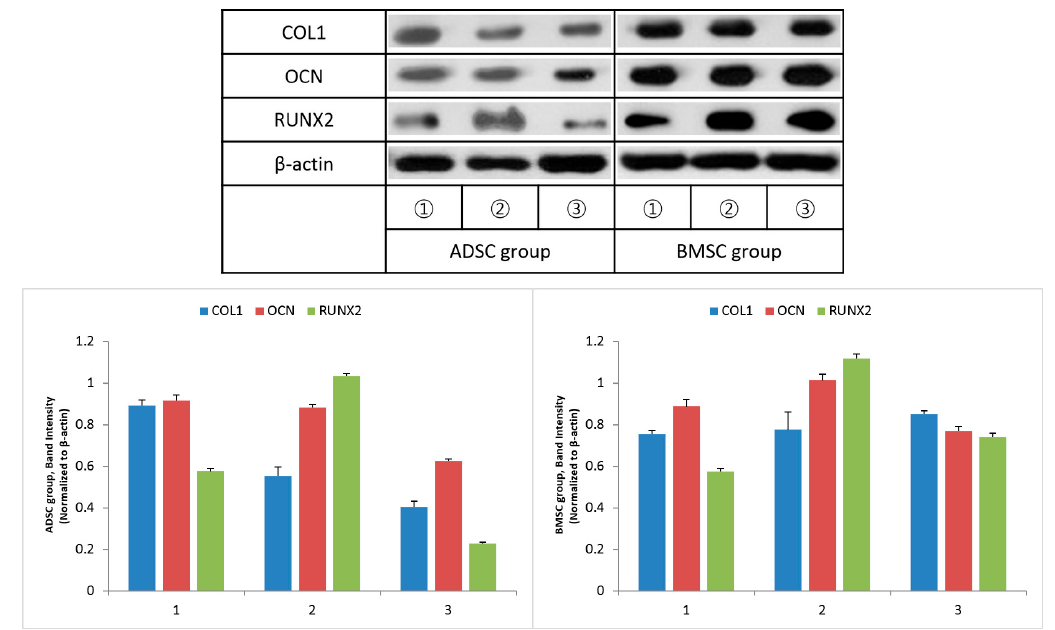
Figure 11. Expression of type 1 collagen (COL1), osteocalcin (OCN), runt-related transcription factor 2 (RUNX2) and β -actin 12 weeks after surgery, measured by Western blot analysis. ADSC, adipose-derived stem cell; BMSC, bone marrow stem cell.